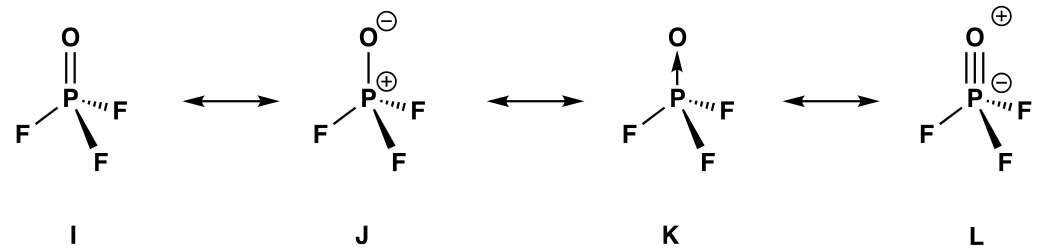
Figure 7. Orbital interaction diagrams showing π -back-donation in POF 3 from the two filled oxygen p orbitals to vacant P–F σ * orbitals of π